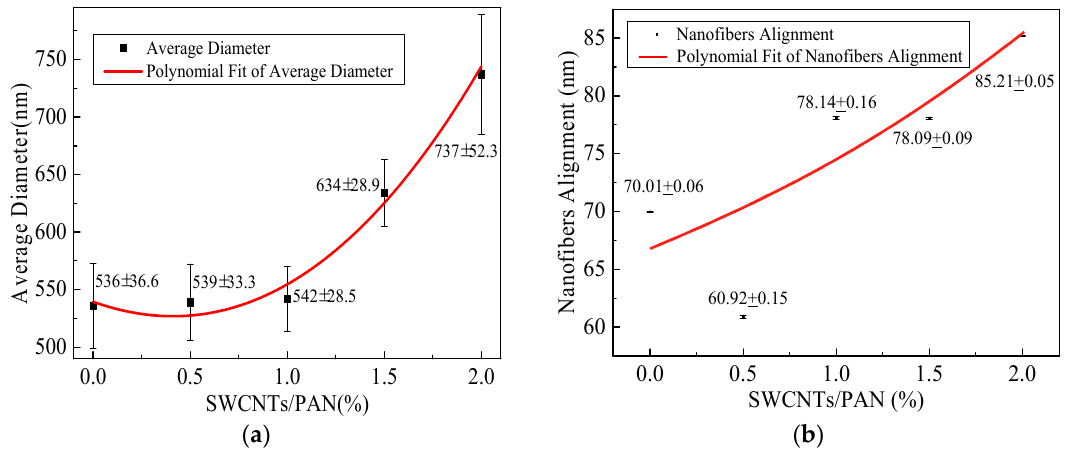
Figure 3. Average diameter and nanofiber alignment of composite nanofibers with the different SWCNTs concentrations. ( a ) Average diameter; ( b ) Nanofiber alignment.